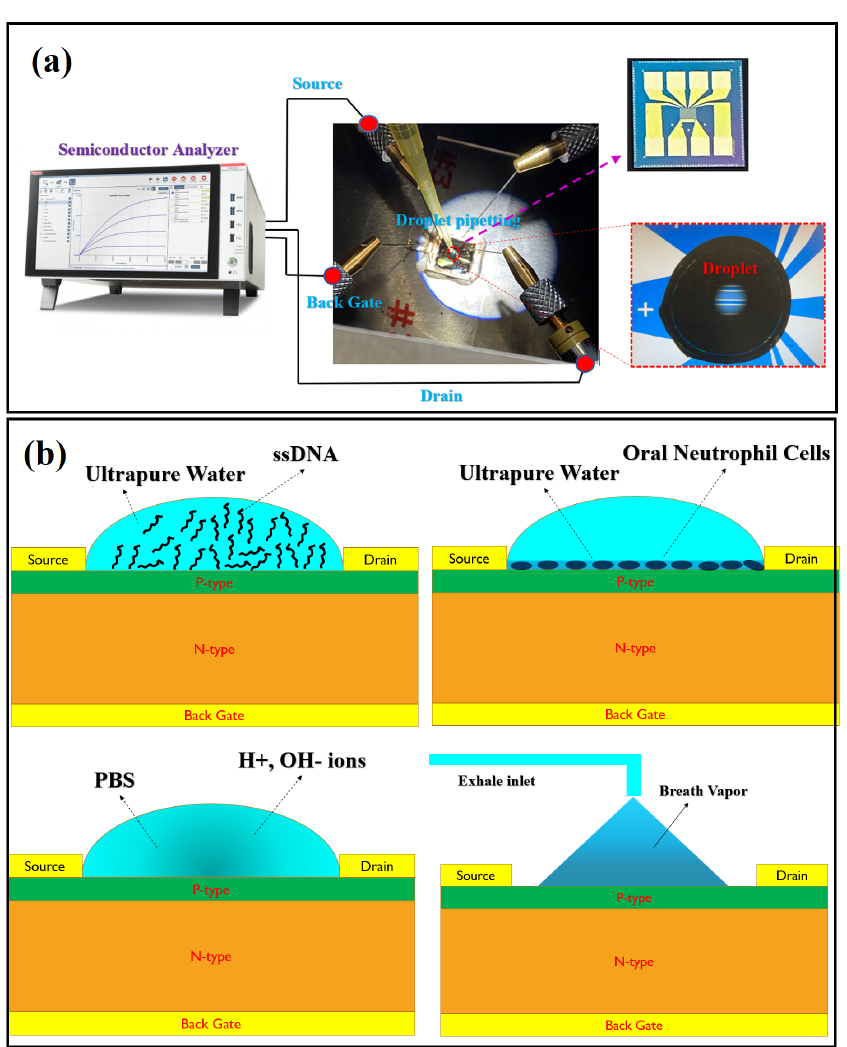
Figure 4. The experiments were set up using probstation and the semiconductor analyzer. ( a ) The probstation was connected to the semiconductors through SMU cables. The droplet containing the analyte of interest was pipetted on the sensor. The droplet volume was 2 µL. ( b ) Different experi- ments developed for the characterization of sensor capability toward surface charge variation de-